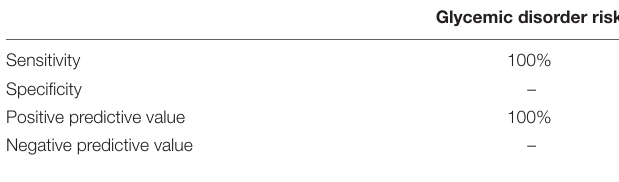
TABLE 2 | Sensitivity (Se), specificity (Spe), positive and negative predictive values (PPV; NPV) for alerts from the MyPredi TM remote monitoring platform.